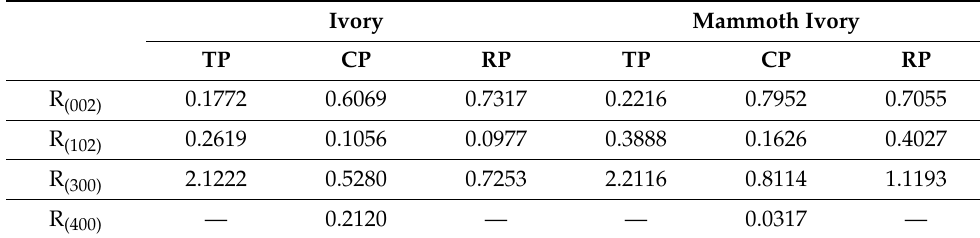
Figure 9. SEM images of the Retzius layer in mammoth ivory: ( a ) lamellar structure in radial plane (scale bar: 10 µm), ( b ) tabular hydroxyapatite in radial plane (scale bar: 100 nm), ( c ) tubules run from the central pulp to the periphery of the outmost layer in circumferential plane (scale bar: 1 µ m), ( d ) collagen fibrils arranged along perpendicular to the long axes of the tubules in circumferential plane (scale bar: 1 µ m). Table 2. Values of the textural index